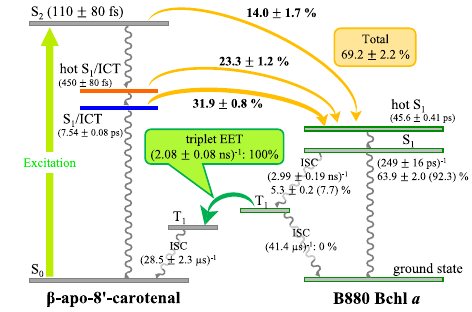
Fig. 7 Schematic illustration of EET and energy dissipation pathways in Re β apo. Denoted values indicate rates and overall ef fi ciencies (quantum yields). The rate of each process is expressed with the inverse of lifetime. ISC stands for intersystem